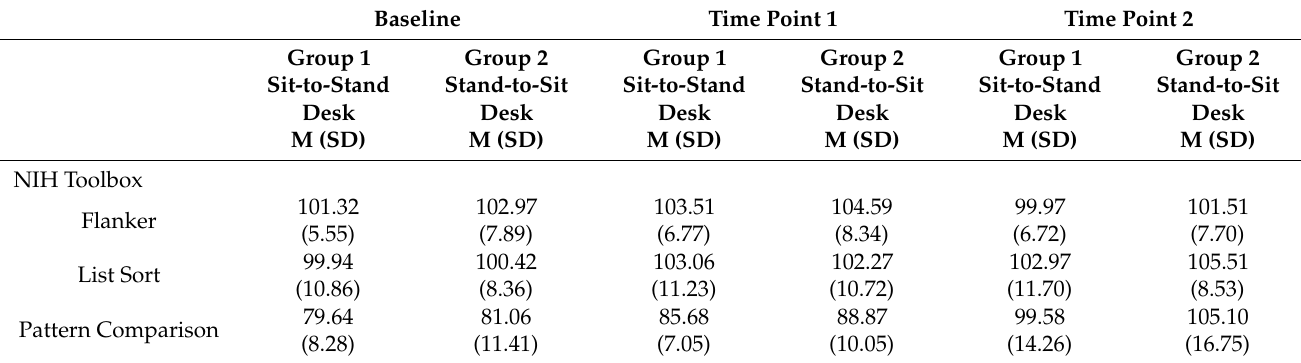
Table 2. Mean Cognitive and Behavioral Ratings Across Time